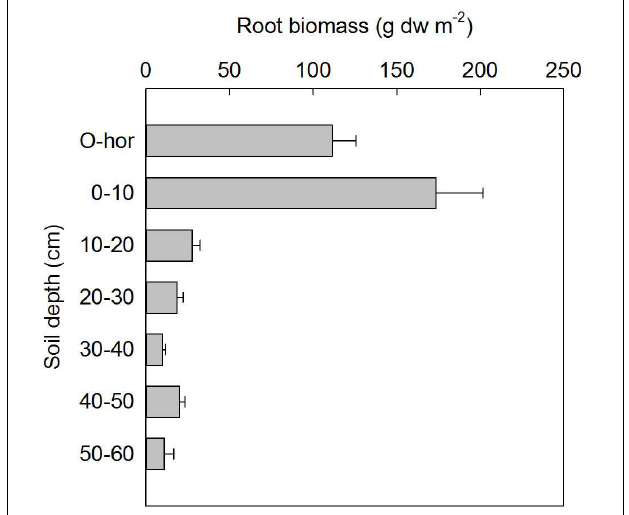
FIGURE 2 | Root biomass (mean ± SE) based on soil samples from all plots in July 2013 at the time of minirhizotron installation ( n = 24).